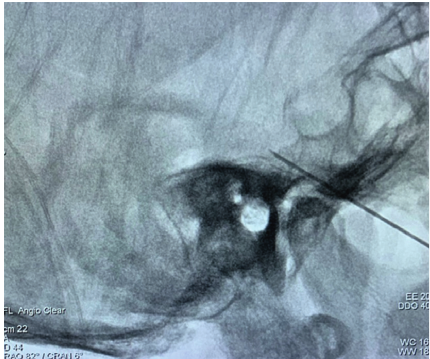
Figure 2: The position of the ophthalmic branch of the trigeminal ganglion is located over the slope line 3mm and the trocar tip was shown in the right position.